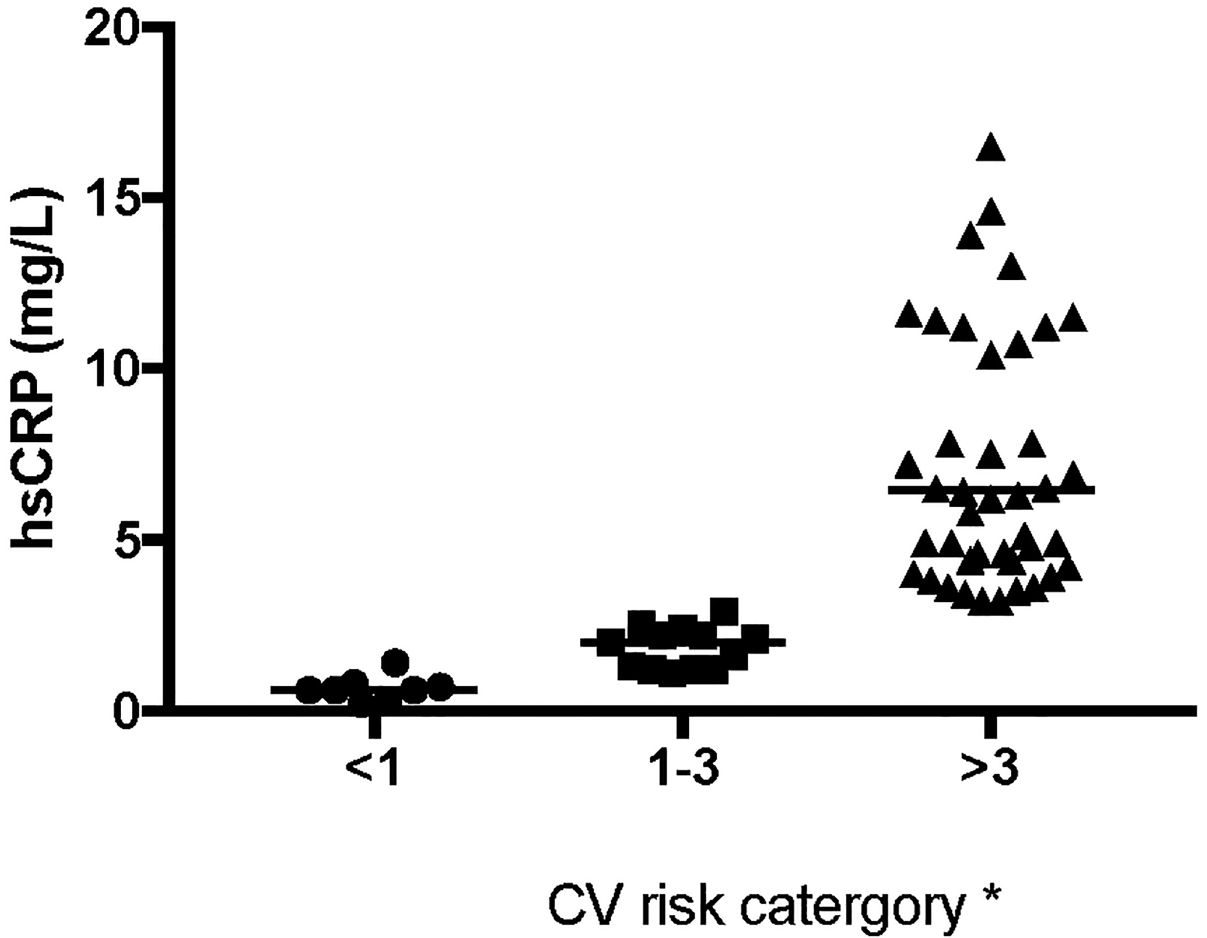
Fig 2. hsCRP levels in study sample. * Risk categories: < 1 low risk, 1–3 medium risk, > 3 high risk, Median value is represented by the horizontalline in each column. 5 data points not shown as outside axis limits (20mg/L). 2 of these samples had levels > 33.1mg/L, however due to variableassay ceilingreliabilitywere capturedas